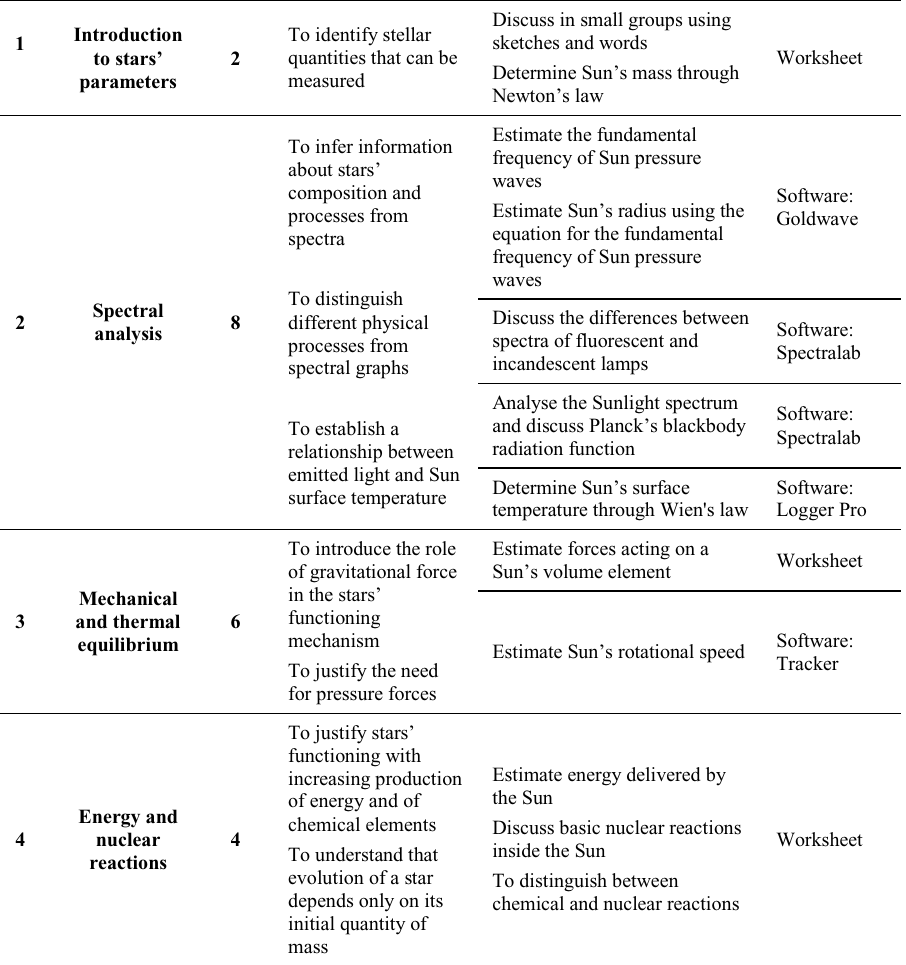
Table 1: Overview of the “Stars and their functioning” student’s